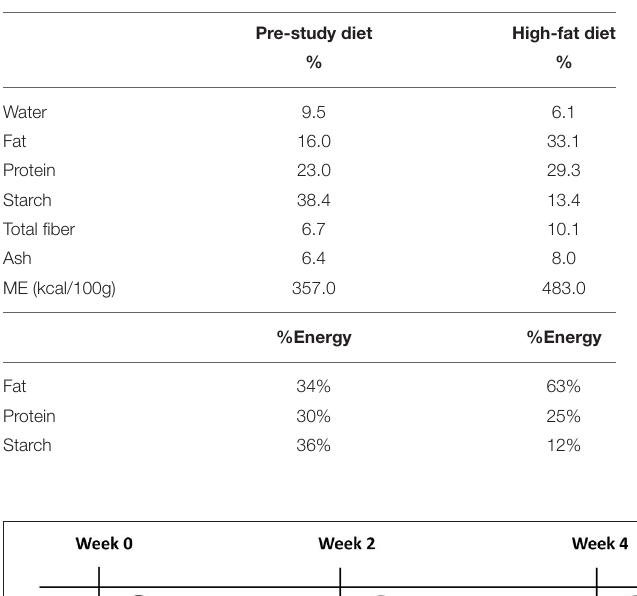
TABLE 1 | Composition of the pre-study diet and high-fat diet on an as-fed and per-energy basis.